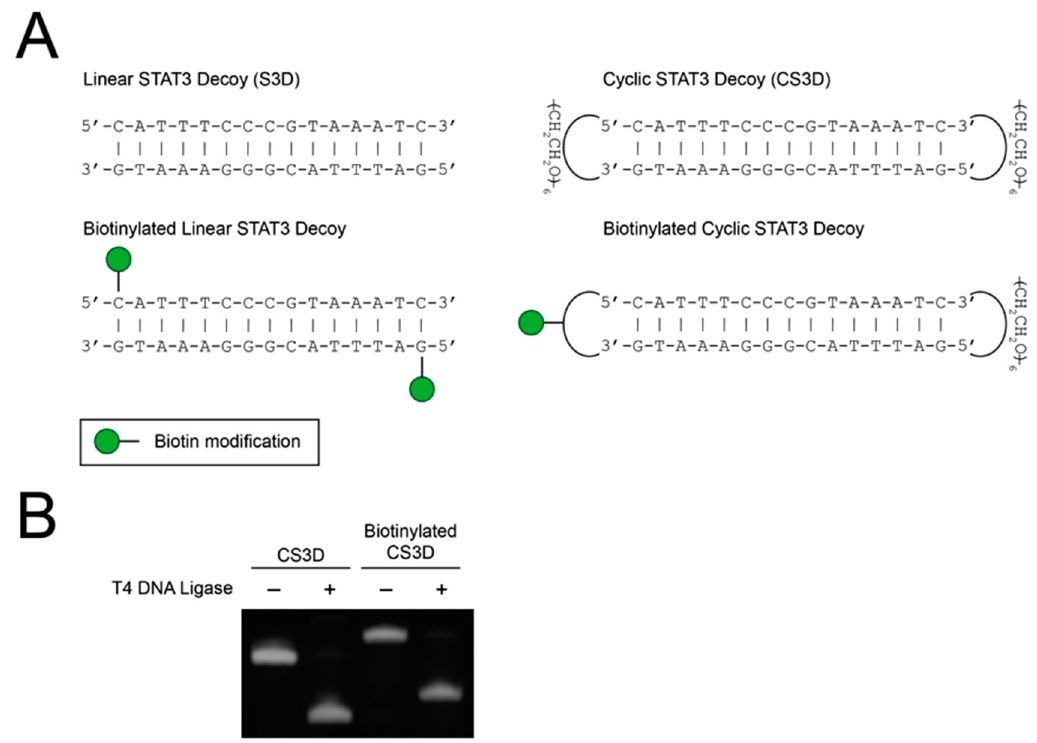
Figure 2. Ligation of cyclic signal transducer and activator of transcription 3 (STAT3) decoy (CS3D) is unaffected by biotinylation. ( A ) Structures of parental and biotinylated STAT3 decoy (S3D) and CS3D. ( B ) CS3D and biotinylated CS3D were incubated with T4 DNA ligase overnight, followed by electrophoresis on a urea/polyacrylamide gel and staining with SYBR Gold.